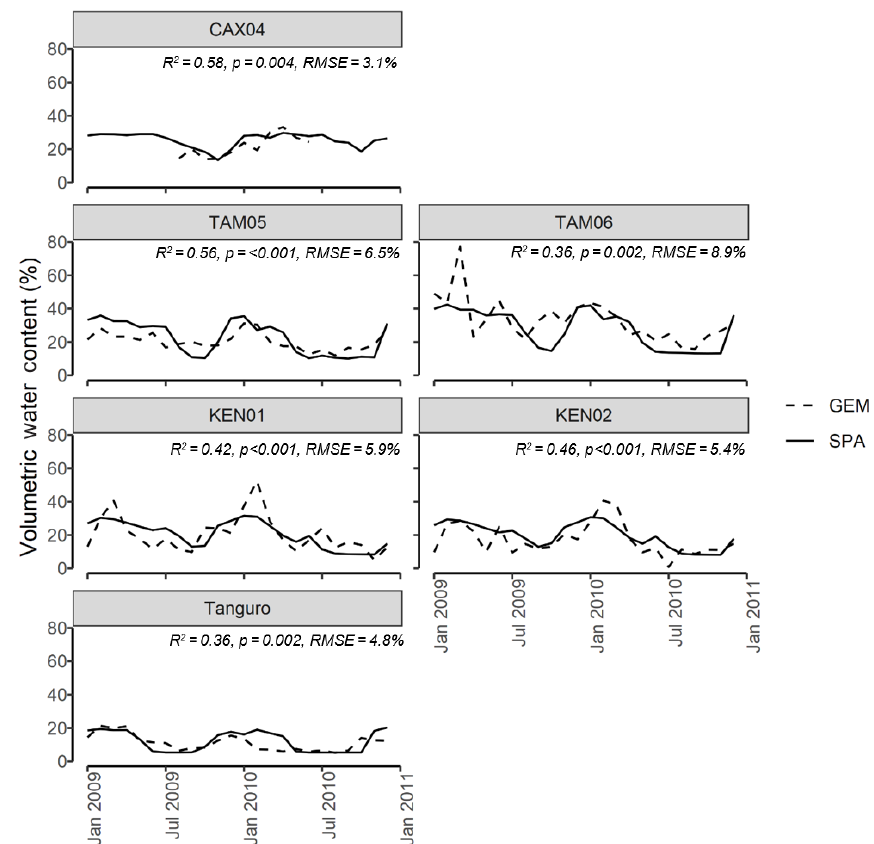
Figure 3. SPA estimated soil volumetric water content compared to GEM measured values for six of the seven sample plots at four locations across the Amazon basin. Data presented are for the time period 2009–2010. Field data for CAX04 were limited to a shorter time period and were unavailable for CAX06. R 2 , p value and RMSE estimates presented are derived from linear regressions between monthly GEM measurements and SPA